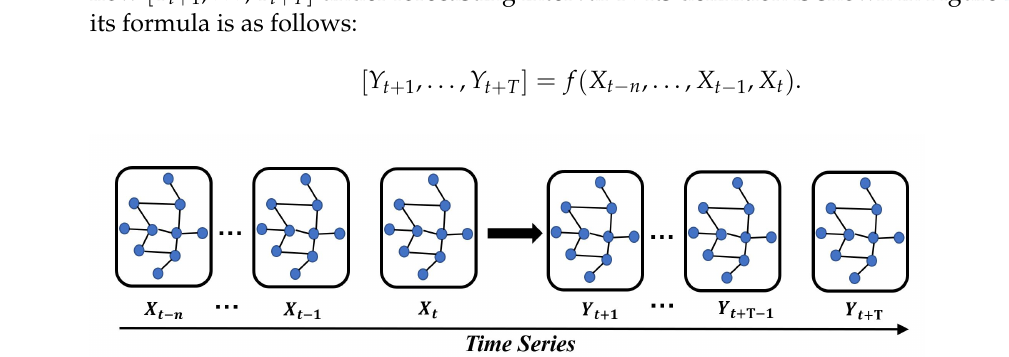
Figure 2. The definition representation of traffic flow forecasting problem.